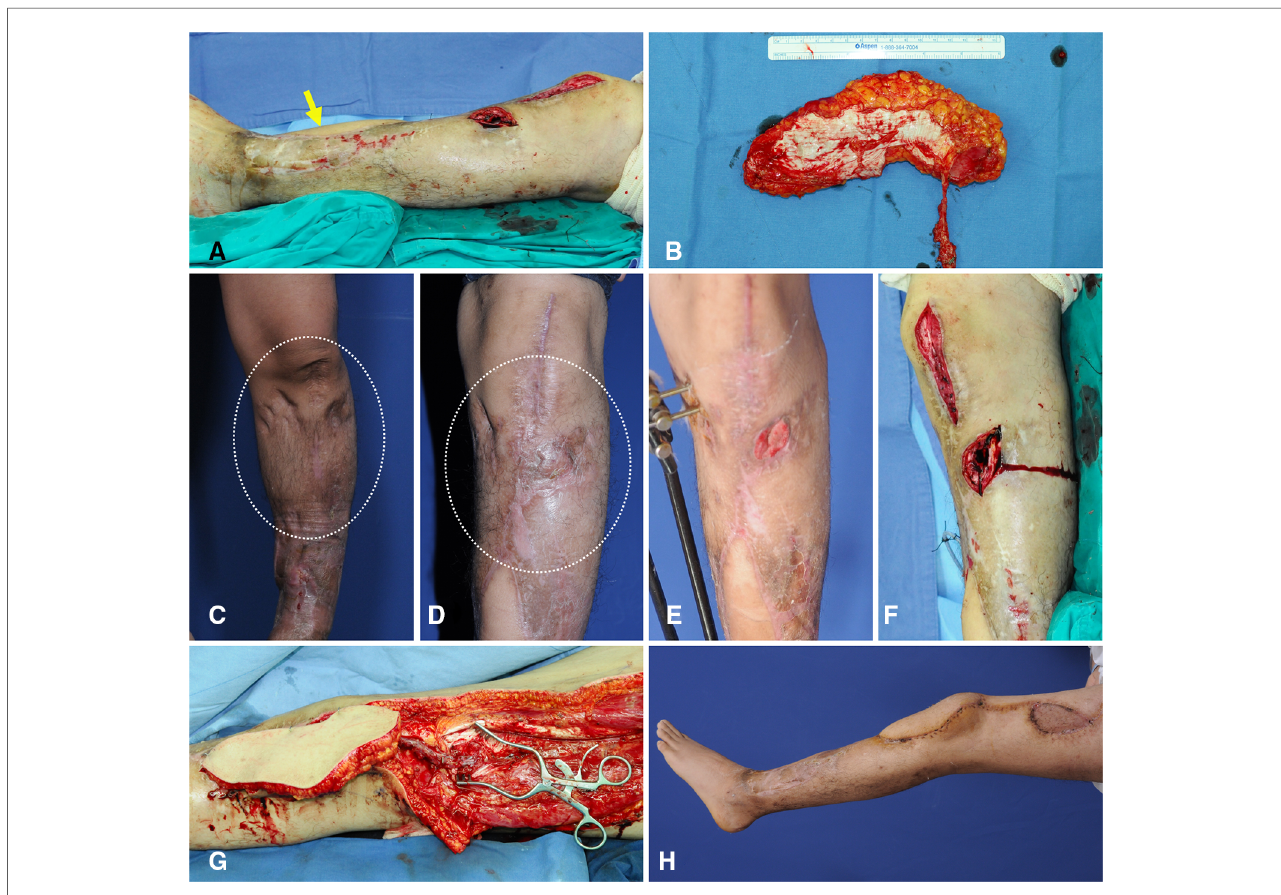
FIGURE 11 A clinical case showing free transfer of Ecc-ALTP fl ap using DB-LCFA and its concomitant veins as recipient vessels for the replacement of injured soft tissues by chronic osteomyelitis. (Case No.13; Algorithmic option No.7) ( A ) Radical debridement of the recurring osteomyelitis-related wound resulted in a soft-tissue defect with a long dimension in a 24-year-old male patient. The defect center was below the patella center. However, the defect extended into upper half of the patella. The yellow arrow indicates the thoracodorsal artery perforator fl ap, which was previously performed to reconstruct the osteomyelitis-related defect. ( B ) Since ATA was dissected and used as a recipient vessel in previous fl ap surgery, LCFA and its concomitant veins were selected as recipient vessels. Then, to provide adequate soft-tissue coverage to the area around the proximal tibia far from the expected vascular anastomosis site to DB- LCFA, an ALTP fl ap with large long skin paddle (21×11 cm 2 ) supplied by an eccentrically located perforator was harvested. ( C,D ) Before the occurrence of the osteomyelitis-related wound on the knee region, the soft tissues around the knee region were already transformed into severely scarred tissues with poor vascularity due to repeated bone surgeries and surgical debridement procedures (White dotted circle). ( E ) When the wound caused by osteomyelitis was created, it was surrounded by multiple incisional scars and hard tissues. ( F ) Orthopedic surgeons debrided infected bone and soft tissues. ( G ) After radical excision of scarred soft tissues by plastic surgeons, the fl ap pedicle was anastomosed to DB-LCFA and its concomitant veins. After additional debridement of unhealthy soft tissues, the transferred ALTP fl ap was secured to adjacent healthy skin. ( H ) Result 2 months postoperatively. (Ecc-ALTP fl ap, anterolateral thigh perforator fl ap with eccentrically located perforators; DB-LCFA, descending branch of the lateral circum fl ex femoral artery; ATA, anterior tibial artery) Table (next